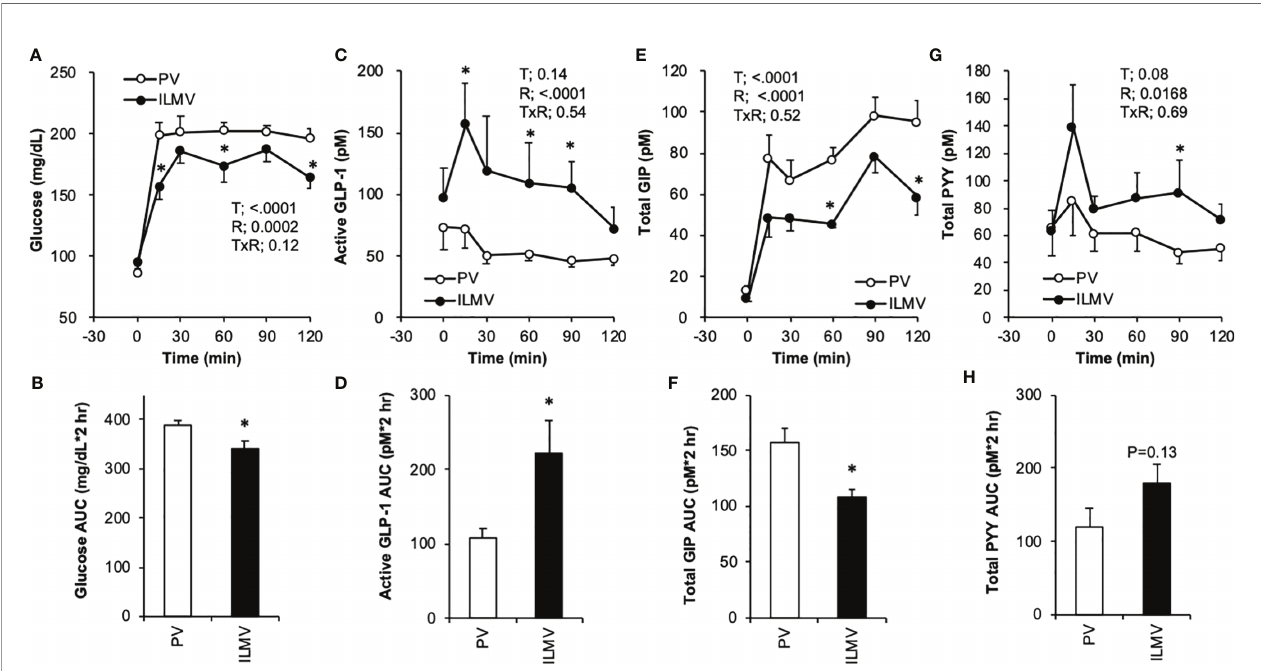
FIGURE 2 | Changes in glucose and gut hormone concentrations in the portal vein (PV) plasma and in the ileal mesenteric vein (ILMV) plasma after ingestion of the standard diet. Rats were provided the AIN-93G diet at the dose of 10 g/kg body weight, after 24-h fasting. Blood samples were collected from the catheter before (0 min) and after providing the meal. Data are presented as mean values and SEM (n = 10 in PV, and n = 6 in ILMV). P values calculated by two-way repeated- measures ANOVA for effects of time (T), the region of blood sampling (R), and their interactions (TxR) are presented in each of the panels. Asterisks (*) indicate signi fi cant difference between the value at the same time point (A, C, E, G) or between the AUC (B, D, F, H) (P < 0.05, Student ’ s